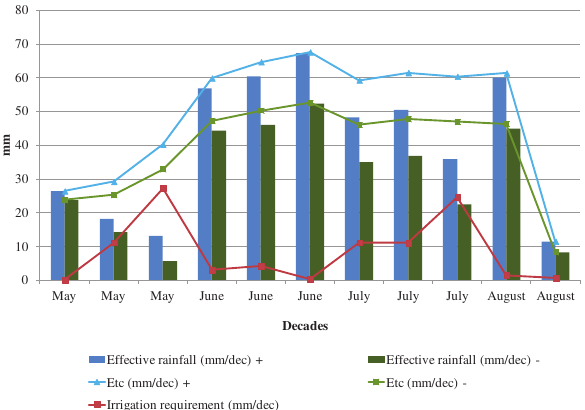
Figure 4. Irrigation requirement and evapotranspiration of Red Haeven in 2003 (+: with active ground cover, –: bare soil)